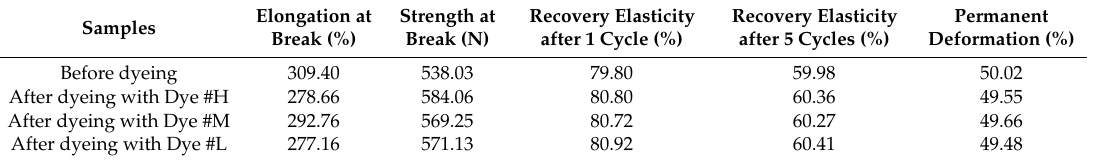
Table 9. Obtained results of elongation at break, strength at break, recovery elasticity, and permanent deformation of bicomponent filaments knitted samples before and after dyeing under optimum